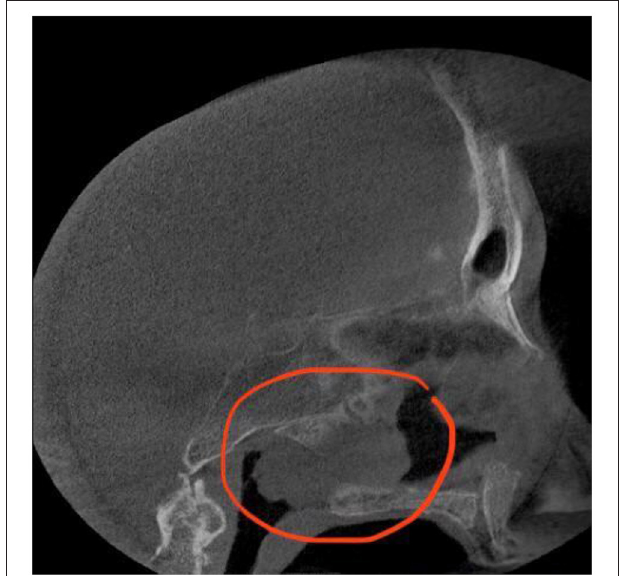
FIGURE 1 | Pre-operative CT scan sagittal